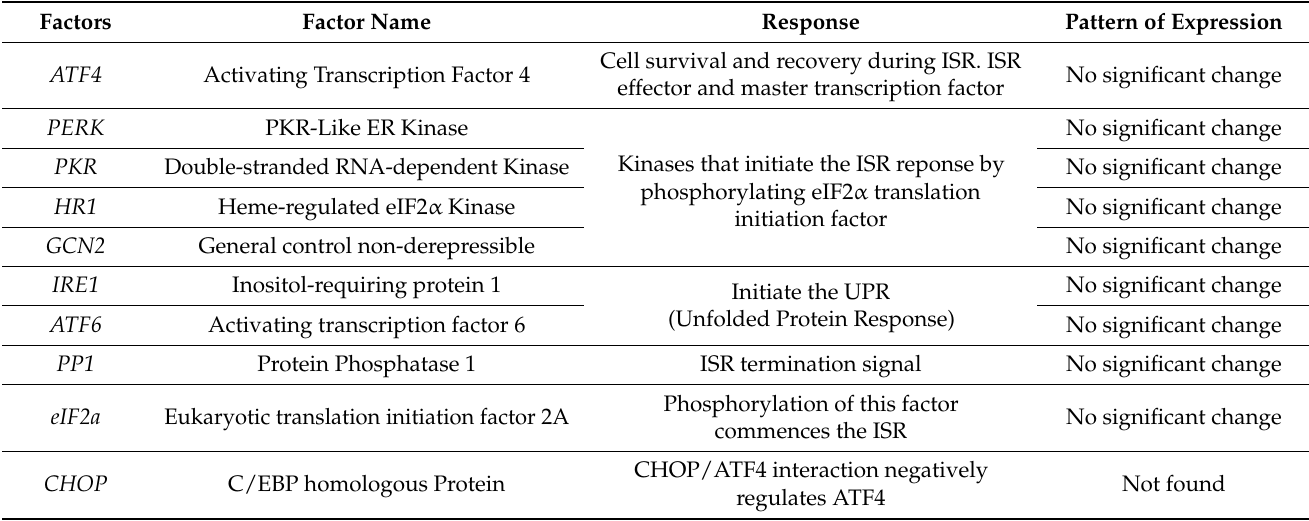
Table 3. Integrated stress response